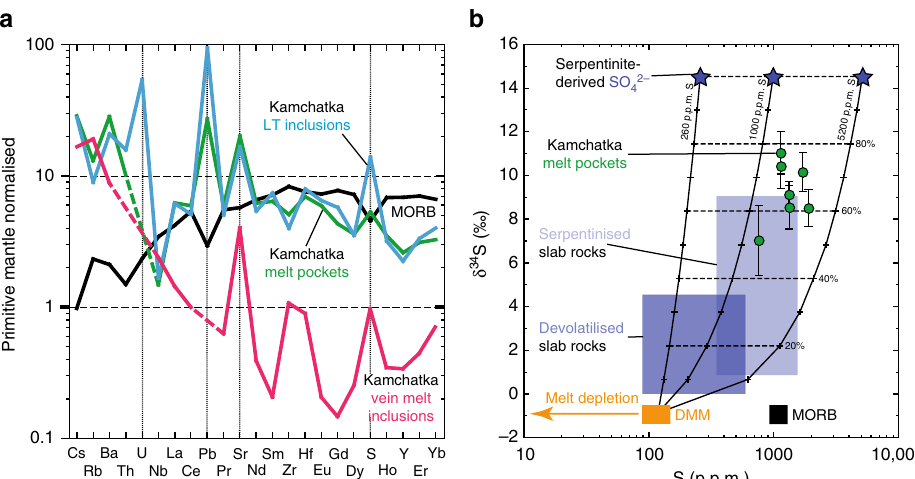
Fig. 4 Lithophile trace element and sulfur isotopic compositions of the studied glass (formerly melt) inclusions. a Primitive mantle-normalised 66 lithophile trace element abundances (averages, Supplementary Table 13) in the glasses 28,29 of Kamchatka LT inclusions (cyan pattern), MP (green pattern) and vein MI (pink pattern) compared to MORB 46,48,49 (black pattern). Sulfur is always enriched in comparison with lithophile trace elements as incompatible as S 2 − (e.g. Dy, ref. 67 ) in the inclusion glasses. This further suggests that S was enriched and/or oxidised in the mantle sources of the inclusion parental melts, since S 6 + is much more soluble than S 2 − in silicate liquids 8,58 . b A δ 34 S ( ‰ ) vs. S content (p.p.m.) plot for MP in this study (green dots, Supplementary Table 11), compared with DMM estimates 46,48,49 (orange fi eld) and MORB data 48,49 (black fi eld). The error bars represent the 2 σ analytical uncertainty on the δ 34 S values reported in this study (Supplementary Table 11). Also shown are high-pressure slab rocks 15 (light and dark blue fi elds) and black mixing lines between a DMM source and agents derived from subducted serpentinite (dark blue stars), as inferred from high-pressure slab rocks 15 , with variable bulk S contents (260 – 5200 p.p.m., exclusively present as sulfate). These variable bulk S contents are calculated to account for different dilution factors of S in agents derived from subducted serpentinite, depending on whether these agents contain only H 2 O and S (5200 p.p.m. S) or more components ( < 5200 p.p.m. S). For this purpose, H 2 O (5 wt%) and S (260 p.p.m.) abundances inferred to be lost by subducted serpentinite 15 are used. The composition of the volatile fraction in the parental melts of MP (S abundances and δ 34 S) is consistent with mixing between DMM and subducted serpentinite-derived agents containing ≥ 1000 p.p.m. sulfate (SO 4 2 − ). Given that the mantle source protoliths of the MP parental melts are more depleted than DMM ( a ), 1000 p.p.m. S in agents derived from subducted serpentinite likely represents a lower bound and the mixing lines could be shifted to the left in b ( ‘ melt depletion ’ , orange arrow). Note that all MP for which S data are presented here are